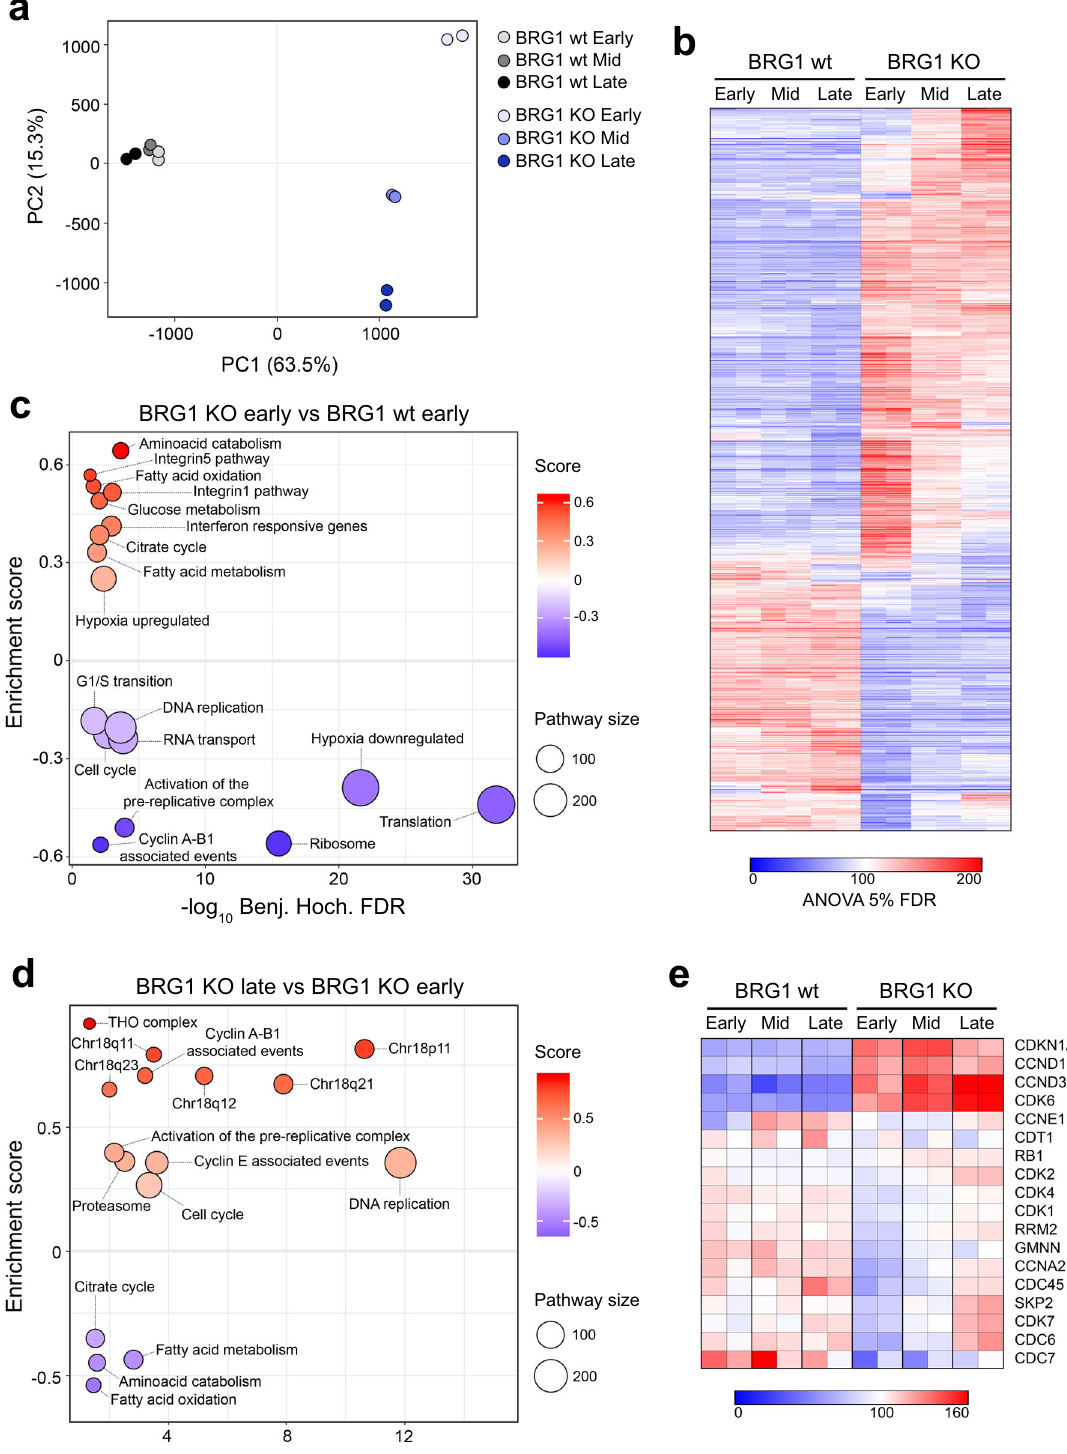
(Fig. 4e). Proteins that are normally expressed during the late G1 or S phase, such as CDC6 and CDC7, are low at early time points in the BRG1 knockout cells, which could re fl ect the decreased S phase population in these cells at this time point (Fig. 2d). Consistent with this interpretation, at later time points the expression levels of these proteins in the BRG1 knockout cells return to those seen in the parental HCT116 cells (Fig. 4e and